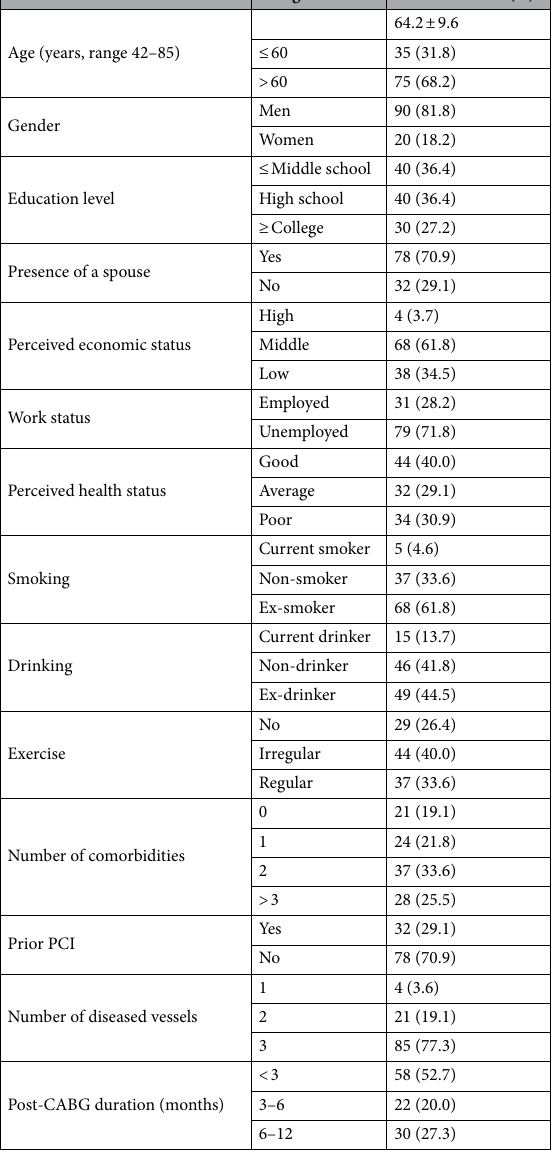
Table 1. Sociodemographic and disease-related characteristics of the participants (N = 110). PCI percutaneous coronary intervention, CABG coronary artery bypass